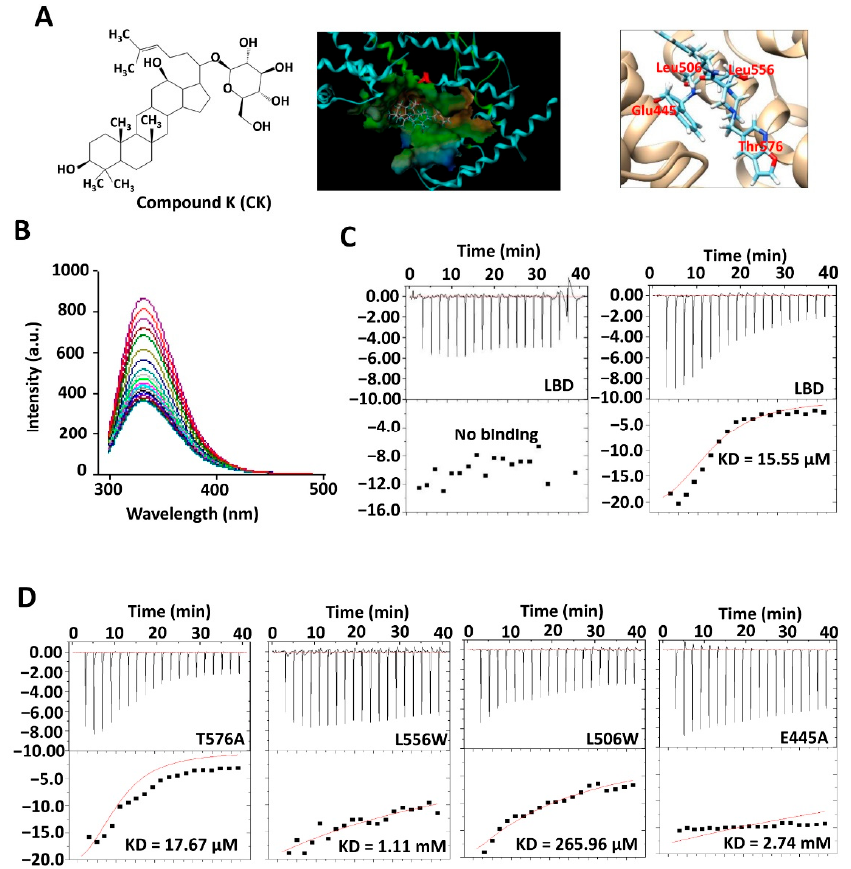
Figure 1. CK is a new ligand for Nur77. ( A ) Chemical structure of CK (left), docking CK into a potential binding pocket (middle) with predicted binding sites of Nur77 based on Autodock virtual analysis (right). ( B ) Fluorescence titration assay. Titrate 1 μ M Nur77/LBD protein in a quartz cuvette with 20 drops of 1 mM CK. The fluorescence was captured and analyzed with sample excitation spectra at 280 nm and emission spectra from 300 to 500 nm. ( C , D ) ITC assay. A sample pool of 50 μ M Nur77/LBD ( C ) or various mutants as indicated ( D ) was titrated with vehicle (left) or 1 mM CK (right) automatically for 40 min. The affinity of CK for Nur77 is expressed as a KD value.